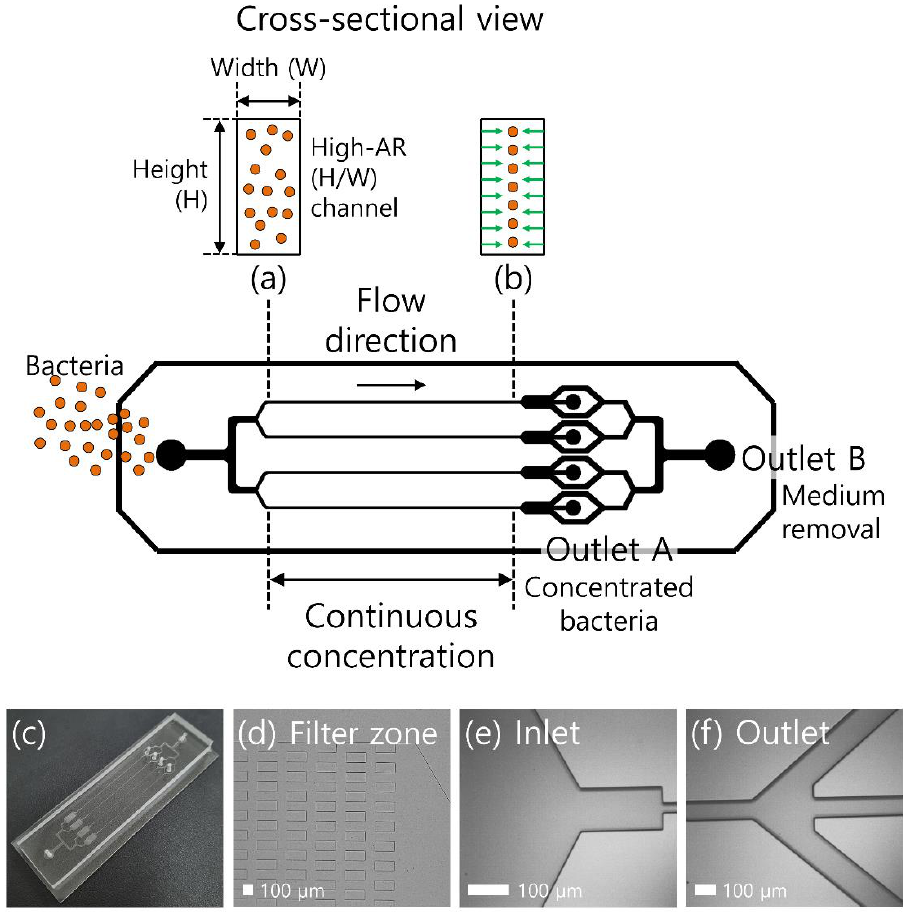
Figure 1. Schematic of the continuous bacterial concentration using viscoelastic fluid. ( a ) Bacteria suspended in a viscoelastic fluid are randomly introduced to the inlet. ( b ) Due to the elastic force, bacteria cells are focused at the center of the microchannel. At the outlet, tightly focused cells are collected at the center outlet (outlet A) and suspending medium is removed to the side outlets (outlet B). ( c ) Image of the fabricated device used in this study for bacterial concentration. Microscopic images of ( d ) the filter zone, ( e ) the inlet, and ( f ) the outlet region of the microchannel.